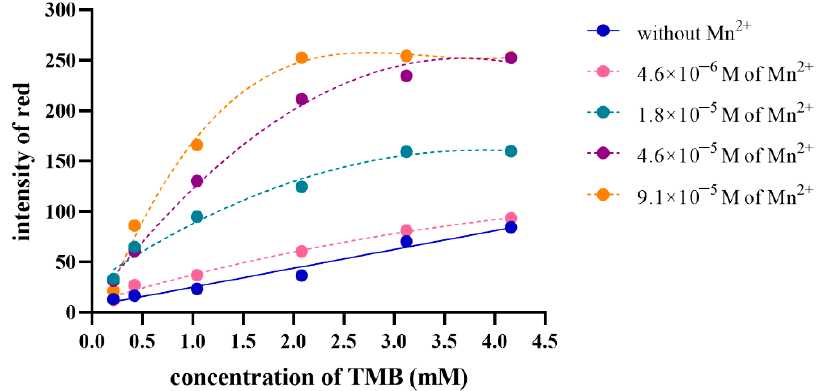
Figure 4. Intensity of the bluish-green, oxidized TMB products as a function of TMB concentration, compared across different Mn(II)-catalyst concentrations (reaction condition: 4.3 mM KIO 4 , 0.1 M phosphate buffer pH 6).